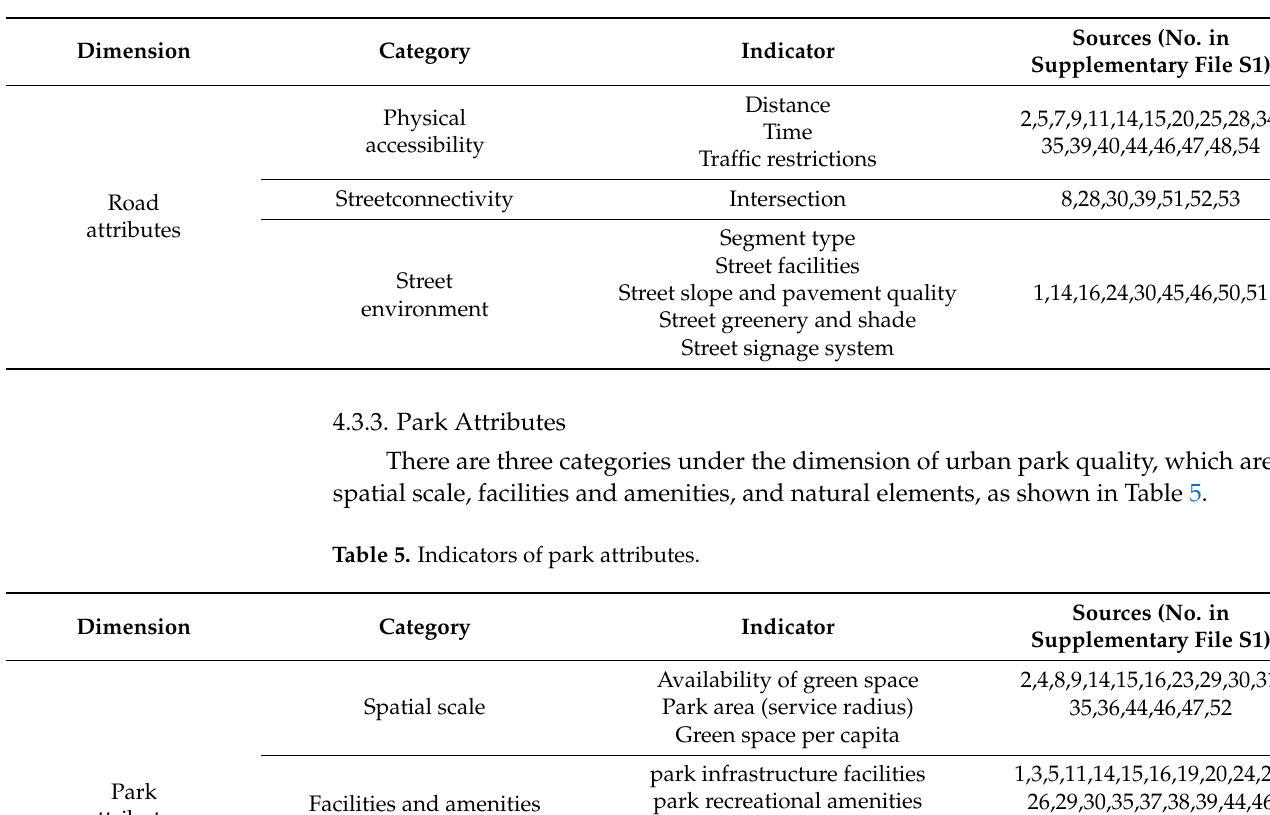
Table 4. Indicators of road attributes.